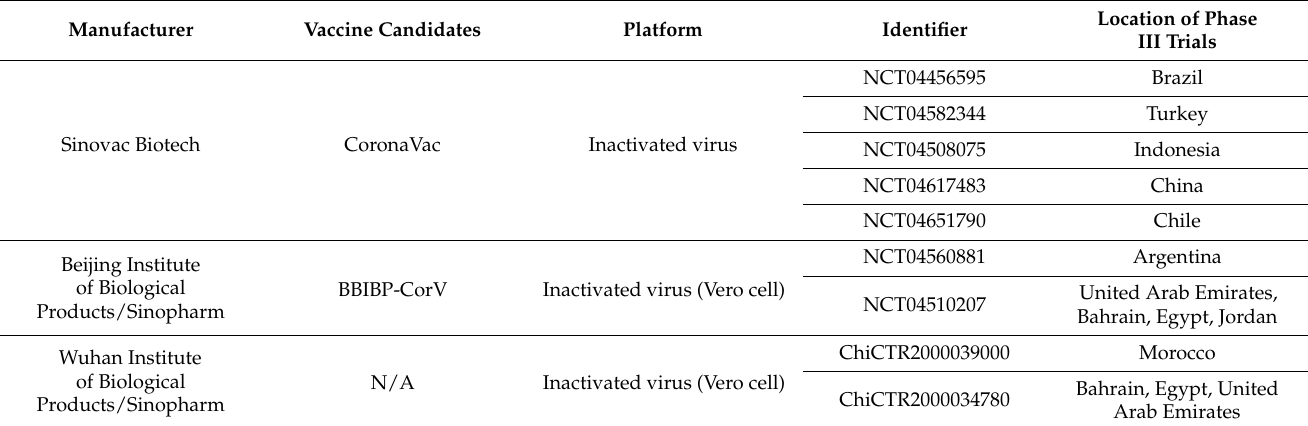
Table 1. Vaccine candidates in Phase III trials as of 30 January